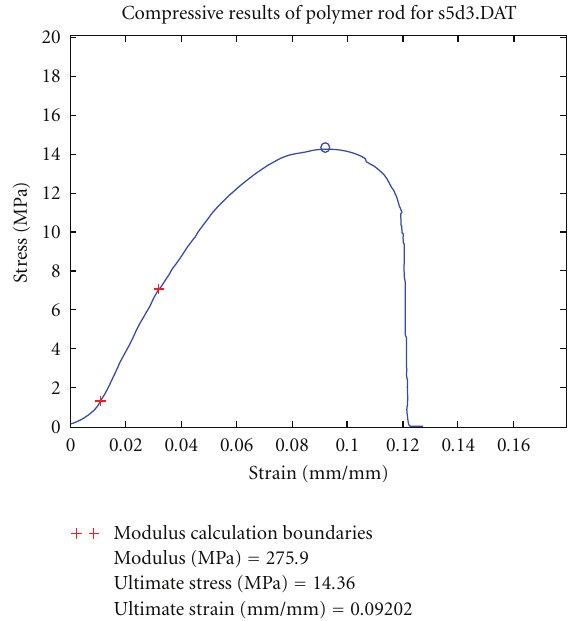
Figure 2: Load and displacement of the representative sample shown in Figure 1 were recorded during compression. The stress- strain curve was then plotted and compressive modulus was calculated as the slope of the initial linear portion of the stress-strain curve, beginning at 1.0% strain. The highest strength achieved was the ultimate strength.